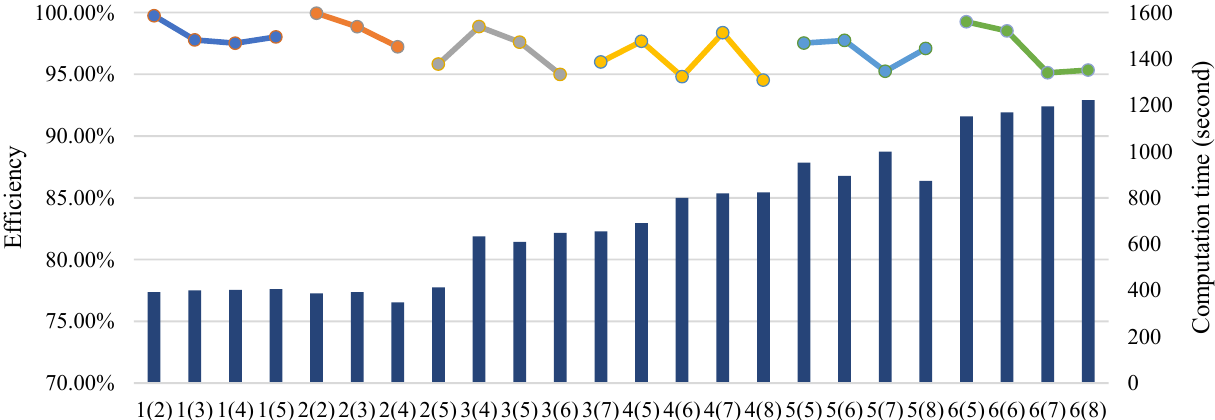
Figure 14. The efficiency of the results of larger problems.